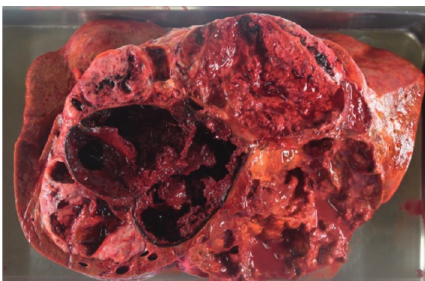
Figure 6: On autopsy, a tumor with necrotic hemorrhage extending throughout the liver could be seen macroscopically, with only little normal liver tissues